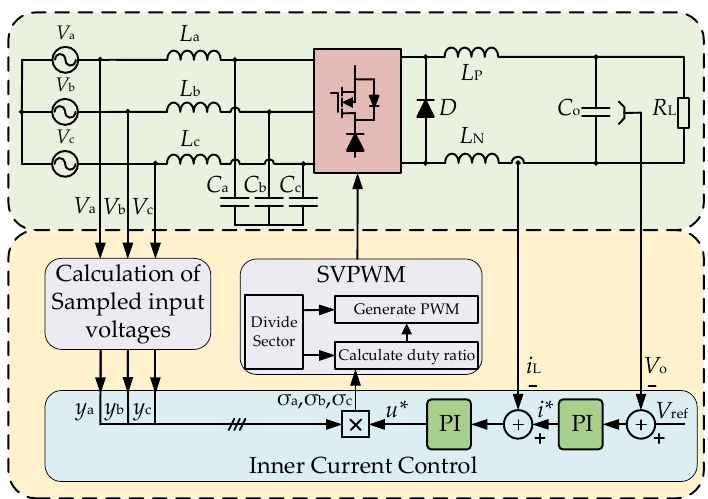
Figure 15. Control block diagram of three-phase six-switch buck recti fi er.